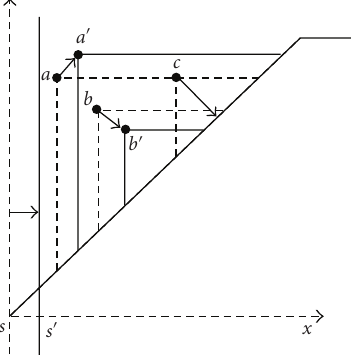
Figure 2: The matching